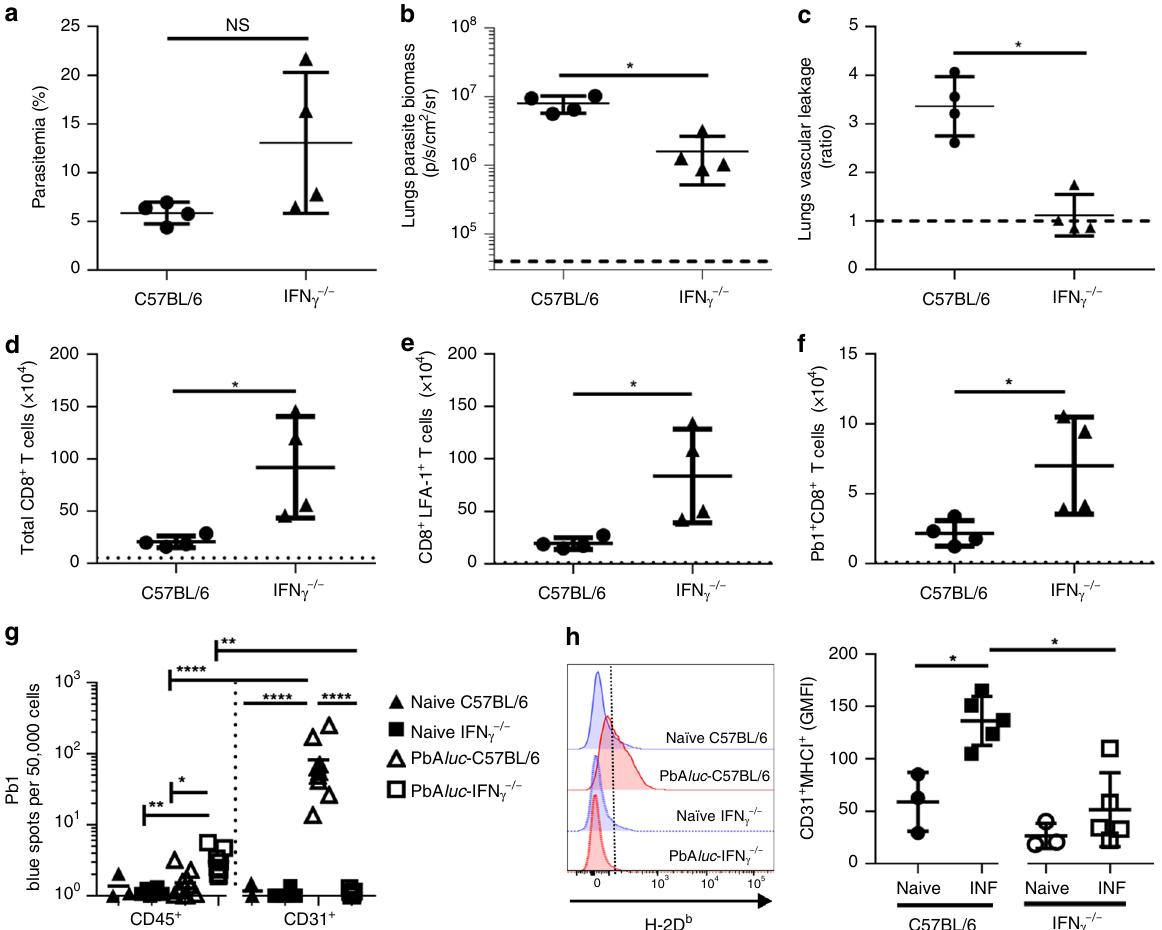
Fig. 7 Absence of IFN- γ prevents lung injury and hinders cross-presentation of malaria antigens by lungs microvessels. a Peripheral parasitemia and b ex vivo quanti fi cation of parasite biomass in the lungs based on luciferase activity after perfusion, of PbA luc -infected C57BL/6 ( n = 4) and IFN- γ − / − ( n = 4) at 7 dpi. c Ratio of in vivo lung vascular leakage measured by Tracer-653 at 7 dpi ( n = 4 in each group). d Total number of CD8 + T, e CD8 + LFA-1 + T and f Pb1-speci fi c CD8 + T cells accumulated in the lungs at 7 dpi ( n = 4). The data shown are representative of three independent experiments. g Lung microvessels were isolated from naïve C57BL/6 (N C57BL/6) ( n = 3), naïve IFN- γ − / − (N IFN- γ − / − ) ( n = 4), PbA luc -infected C57BL/6 ( n = 10) and PbA luc -infected IFN- γ − / − ( n = 9) mice at 7 dpi. Each population was tested for Pb1 cross-presentation. The spot count was normalized per 50,000 cells and represented on a log scale. h Representative histograms of lung endothelial cells (CD45 − CD31 + ) from naïve C57BL/6 ( n = 3) and IFN- γ − / − ( n = 3) mice (blue line), and PbA luc -infected C57BL/6 ( n = 4) and IFN- γ − / − ( n = 5) mice (red line) at 7 dpi that were stained for MHC-I (H-2D b ). Graphs represent the geometric mean fl uorescence intensities (GMFI) of MHC-Class I (H-2D b ) on CD31 + lung endothelial cells from naïve and infected (INF) mice. For ex vivo quanti fi cation of parasite biomass in the lungs in ( b ), data are expressed on a log scale, with naive mice represented by the black dashed line. The black dashed line at y = 1 in ( c ) represents the ratio of tracer reading from naïve mice ( n = 3). The black dotted line in ( d – f ) represents the value of each respective cell population from naïve mice for quanti fi cation of the immune-cell populations in the lungs. The data represent the mean ± SD; NS: not statistically Signi fi cant, * p < 0.05, by Mann – Whitney test ( a – f , h ); * p < 0.05, ** p < 0.01, **** p < 0.0001, by ANOVA with Bonferroni ’ s post-test ( g